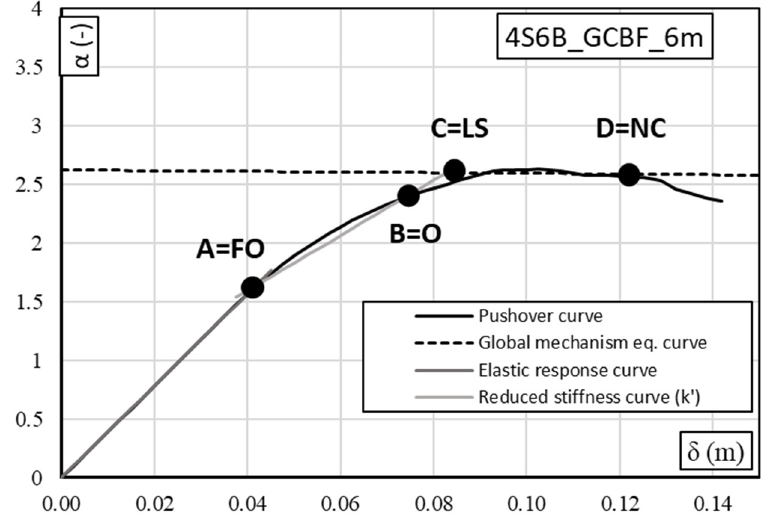
Figure 6. Trilinear model and characteristic points for the structure 4S6B_GCBF_6m